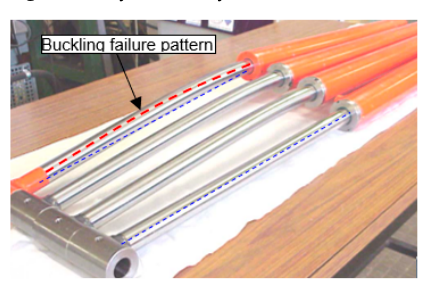
Figure 2. Buckling failure pattern.